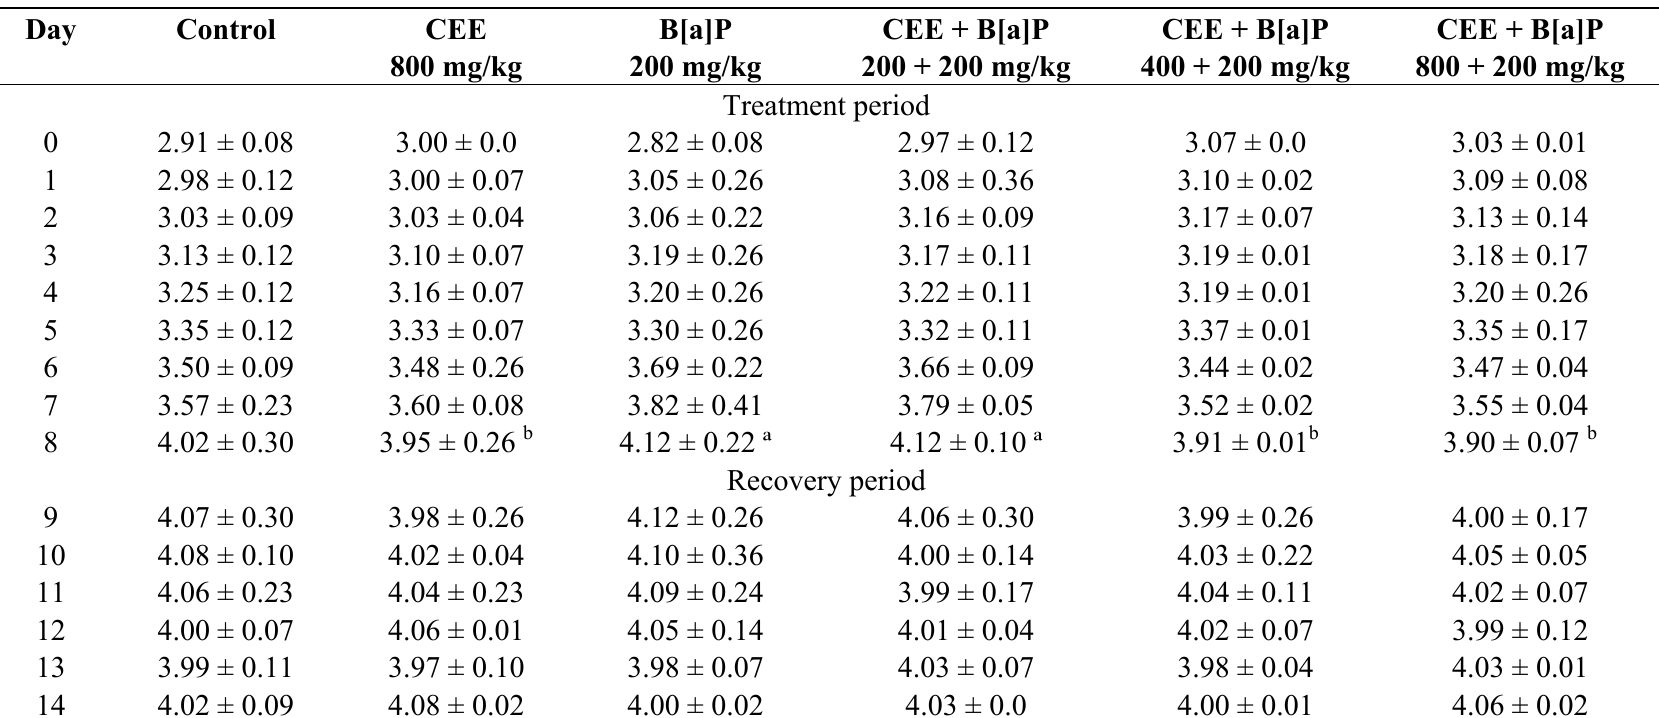
Table 2. Food consumption (g) in mice treated with cranberry ethanolic extract (CEE) and benzo[a]pyrene (X ±